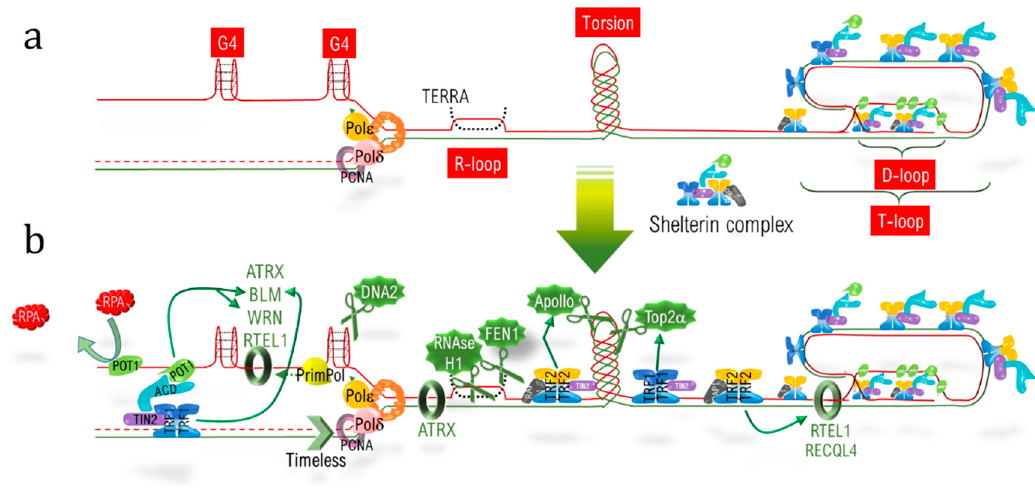
such as torsions and a condensed heterochromatic environment.